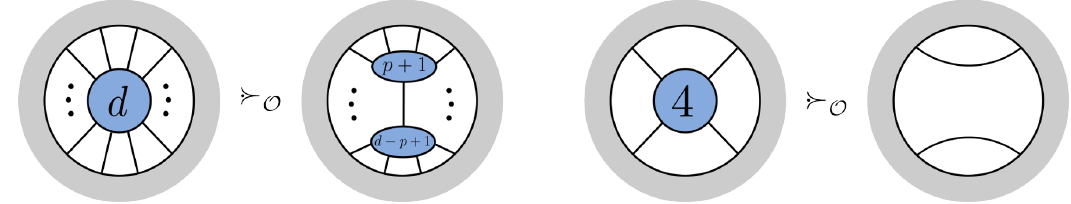
Figure 6 . A graphical illustration of the covering relations ≺· O in the case when deg ( v ) > 4 (left), and deg ( v ) = 4 (right). The grey boundary indicates that these are part of some larger graph, and the numbers inside the vertices indicate their